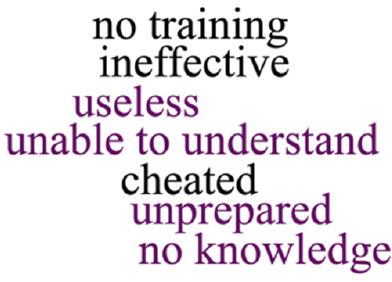
Figure 1. Common responses regarding teacher preparation.